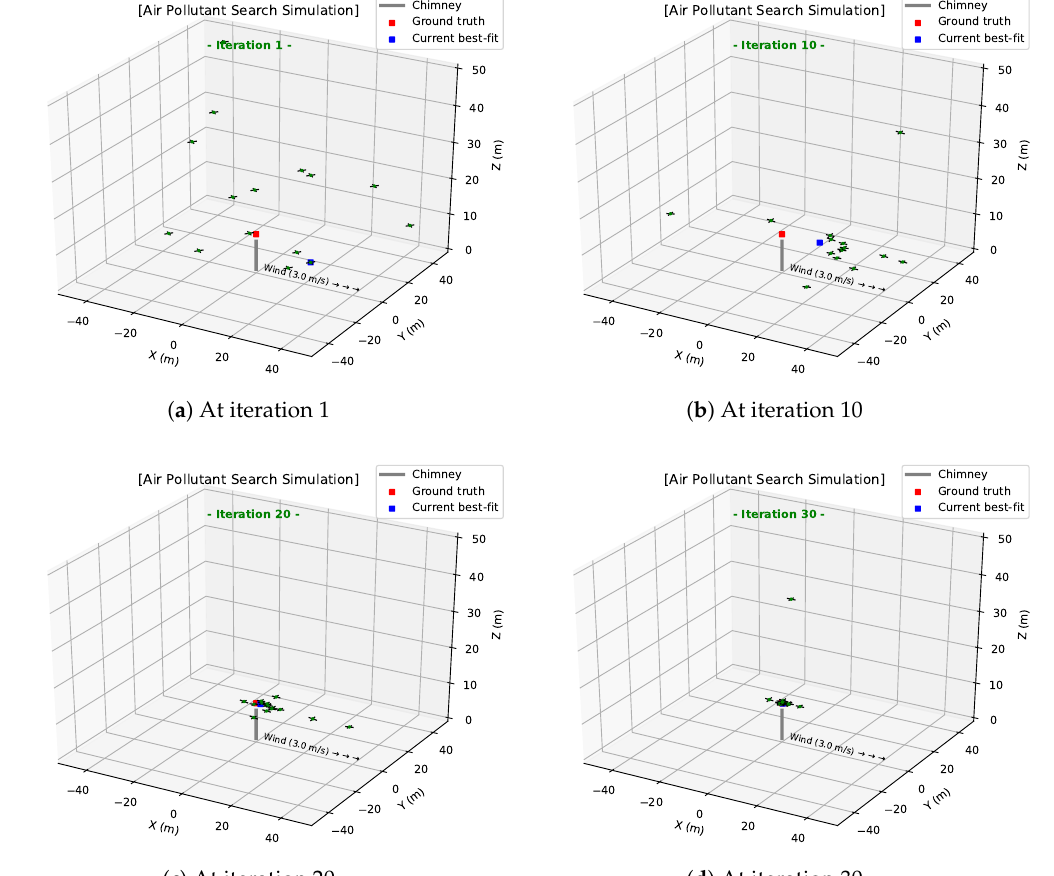
Figure 5. Screenshots of the simulation of Test Problem 2 by the proposed